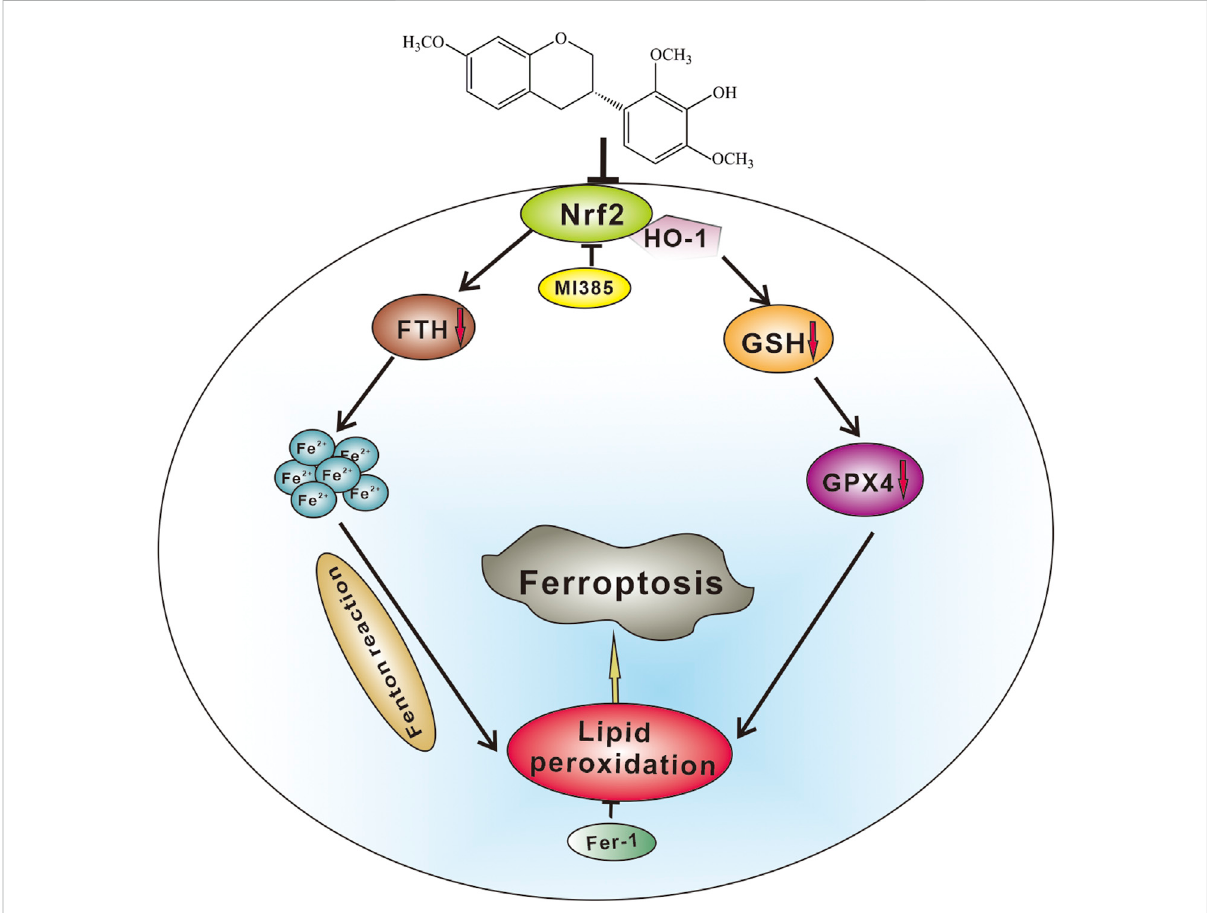
FIGURE 8 A hypothetical molecular mechanisms of ShtIX-induced ferroptosis in NSCLC cells. ShtIX induces NSCLC cells ferroptosis by inhibiting Nrf2/ HO-1 signaling